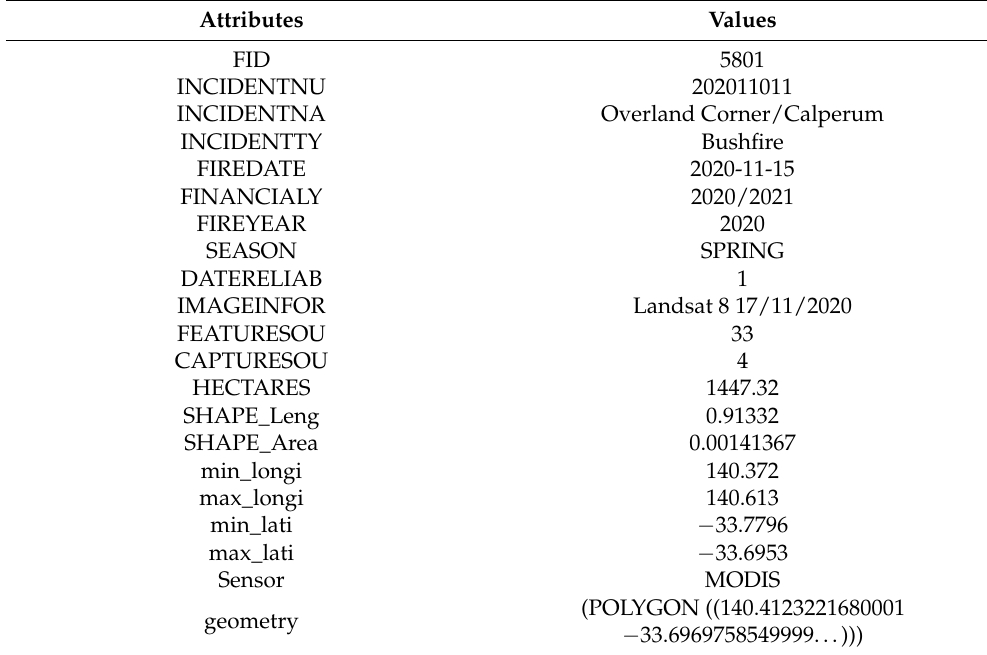
Table 3. A sample record in the SA historical fires